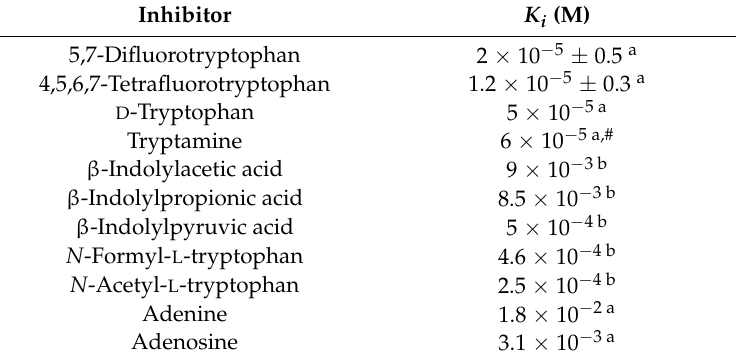
Table 1. Reversible substrate-like inhibitors of bovine Tryptophanyl tRNA Synthetase (TrpRS)